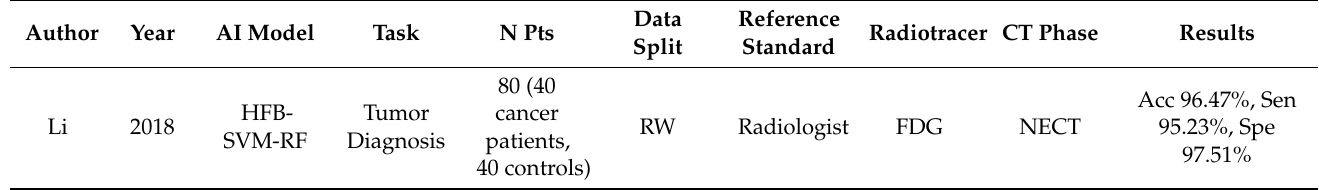
Table 7. Applications of CAD in pancreatic PET-CT